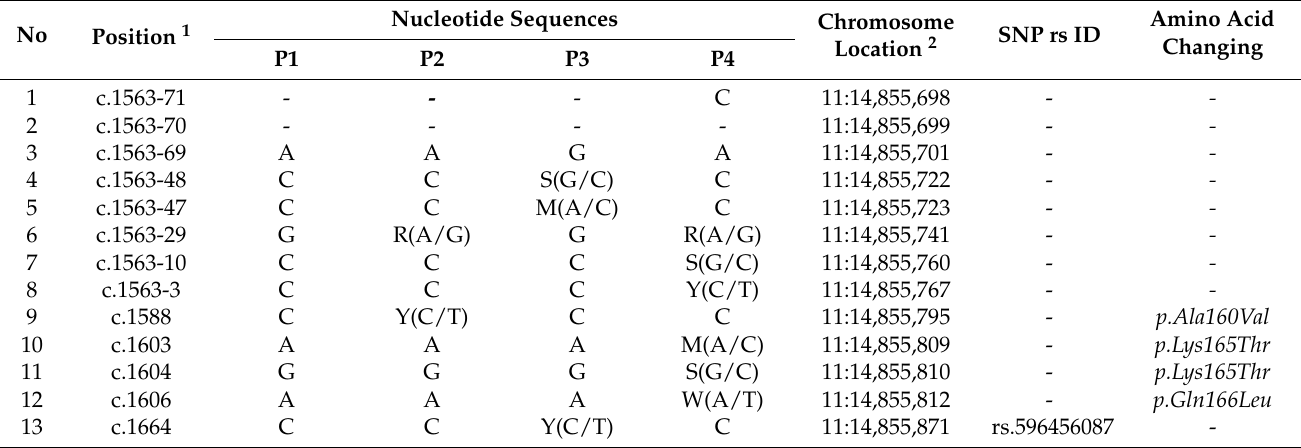
Table 2. Sequence variation in GHE5.